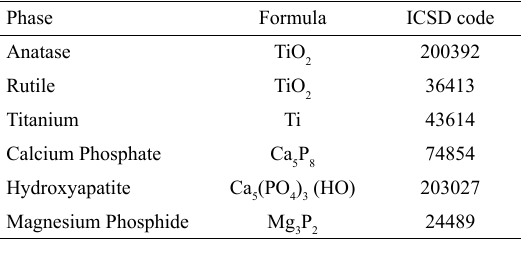
Table 1. Structural model (ISCD database) of the possible phases present in the PEO coating.